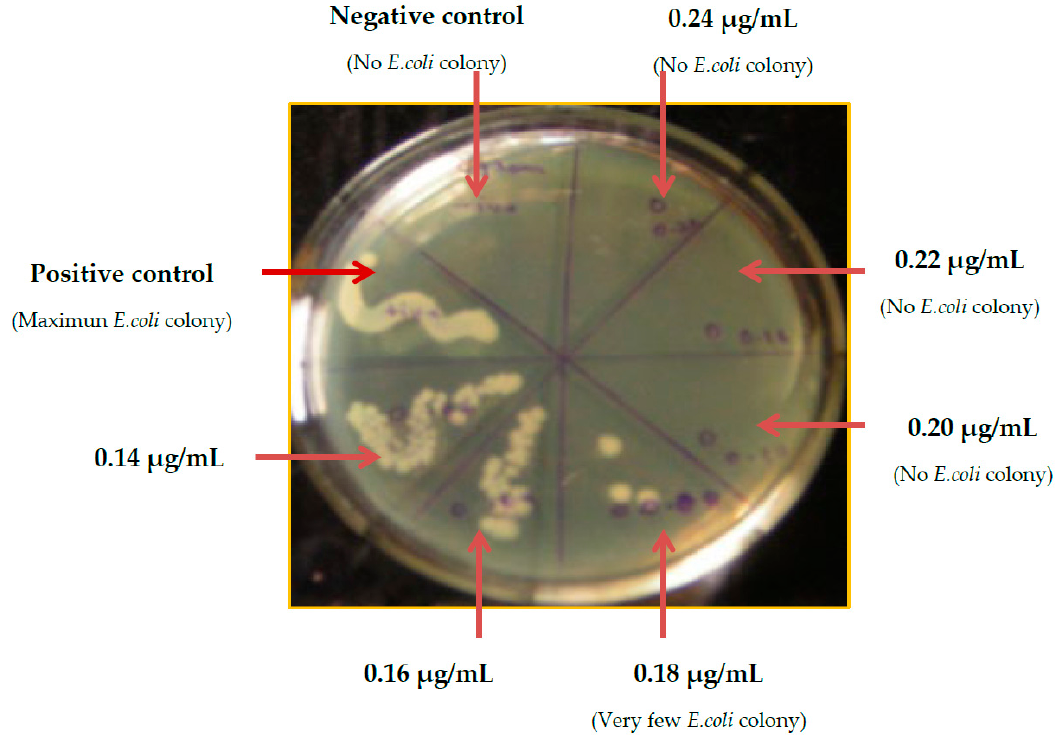
Figure 6. Minimum inhibitory concentration (MIC) observation of G-S for E. coli by visual detection of colony forming units (CFU).